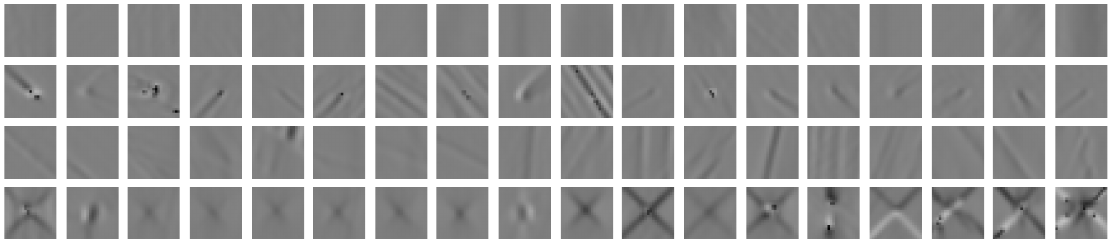
Figure 2. Topography image examples randomly selected from our sample